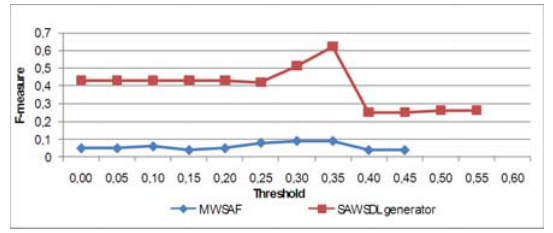
Fig. 6. The F-measure curves for the matching process of the two approaches From this graph we see that the results obtained by MWSAF are underperforming compared to SAWSDL Generator whatever the chosen